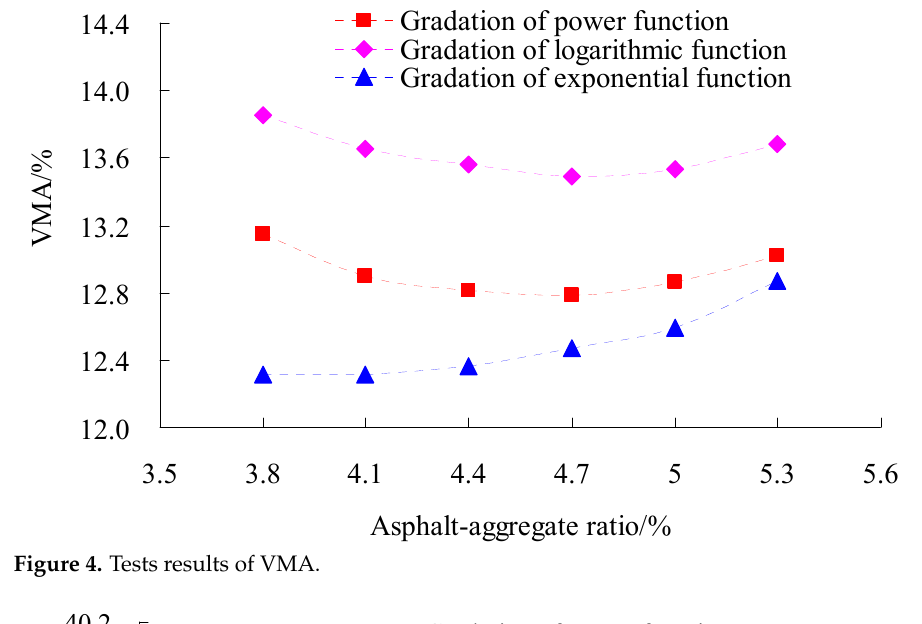
Figure 4. Tests results of VMA.